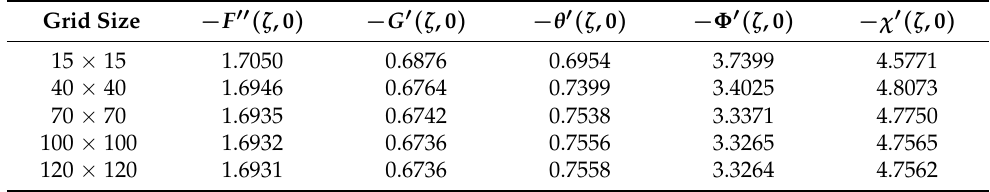
Table 1. Meshing analysis for various mesh dimensions when ζ = 1.0.